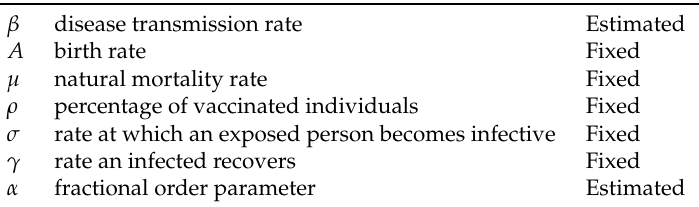
Table 1. Parameters of the measles